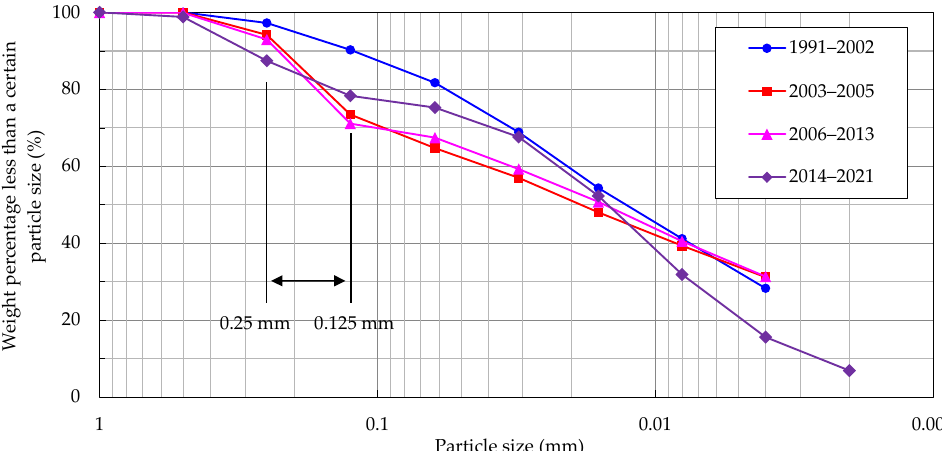
Figure 4. Variation of suspended load gradation in different periods at Shashi station.